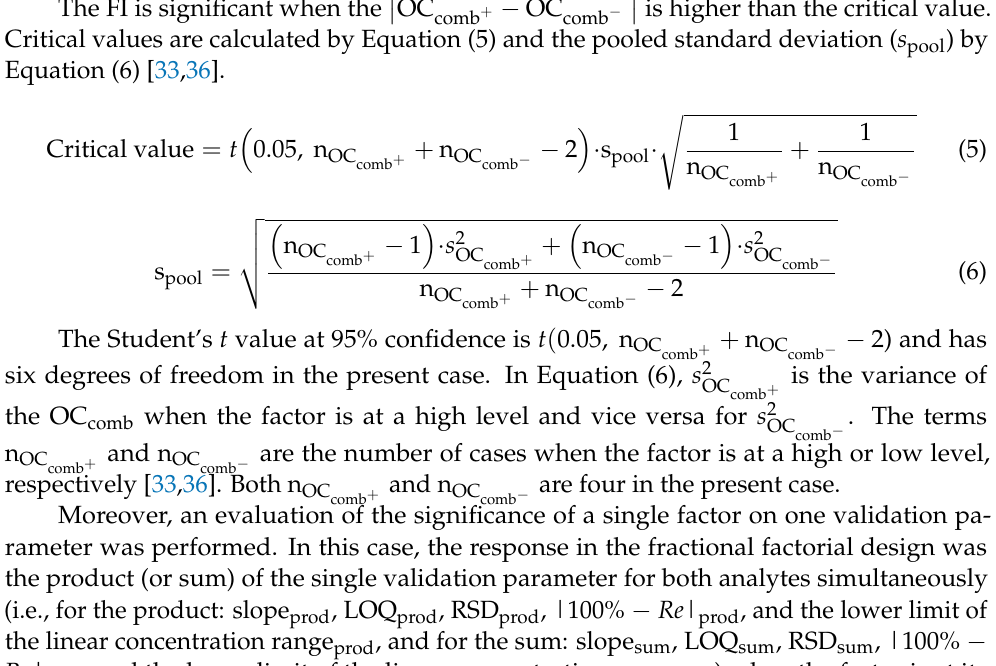
(cid:12) (cid:12) − OC (cid:12) OC (cid:12) is higher than the critical value. comb + comb −